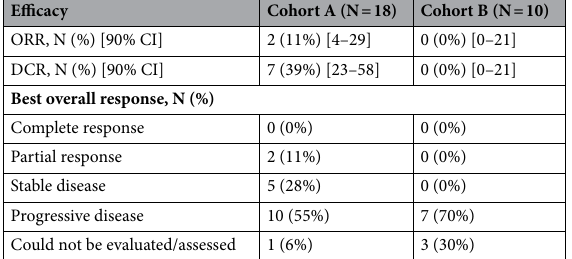
Supplemental Table S1. Three out of seven patients received RT for bone metastasis in the pelvis. Four patients showed clinical benefit to breast or liver lesions. Tumor sample was not available in one patient who experienced stable disease. PD-L1 expression was negative in the other six patients. Median PFS was 4.1 months (95% CI 2.1–6.1 months) and 2.0 months (95% CI 1.2–3.7 months) in cohorts A and B, respectively (Fig. 3). The median duration of treatment with nivolumab was 23.4 weeks (range 0.1–62.1 weeks) in cohort A and 6.1 weeks (range 0.1–12.3 weeks) in cohort B. Safety.